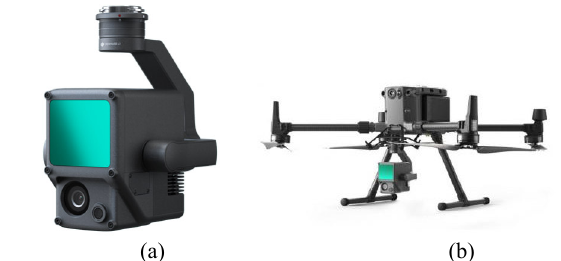
Figure 1. The Zenmuse L1 (a) and the system mounted as payload with the DJI Matrice 300 (b).